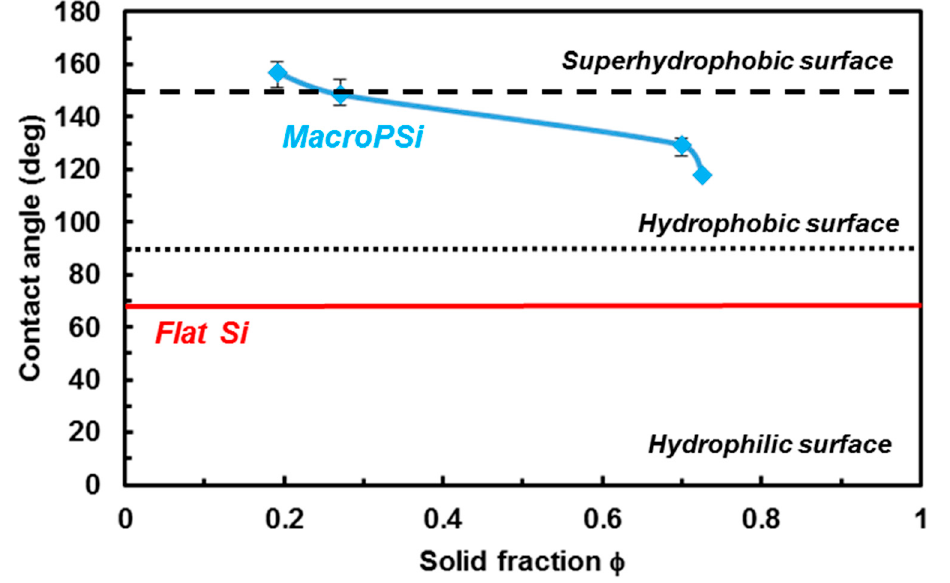
Figure 4. Experimental water contact angle results of MacroPSi substrates as a function of solid fraction.